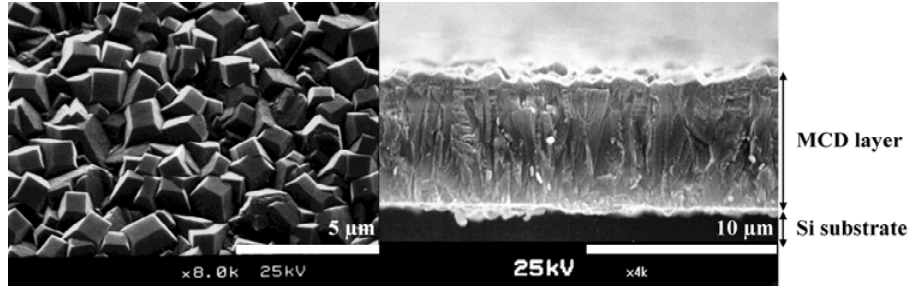
Figure 3. SEM images of a MCD film on Si. In a topographical view, the µm-sized grains on the surface are clearly visible (left panel). The cross-section shows the columnar growth nature of these grains (right panel) (University of Bristol, UK, CVD Diamond Film Group)